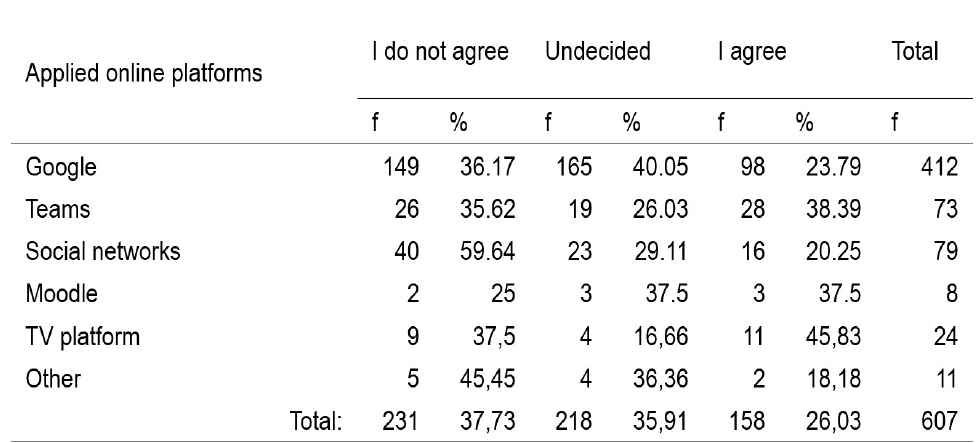
Teachers’ views on material and technical equipment of students / applied online